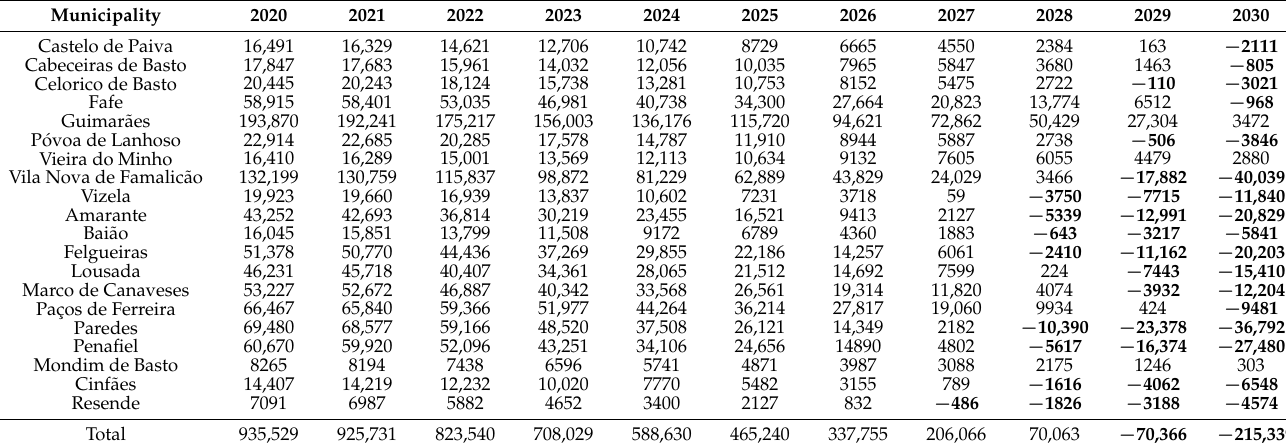
Table A7. Scenario 3: Impact (available power–required power) of the BEV fleet on the grid during off-peak hours (values in